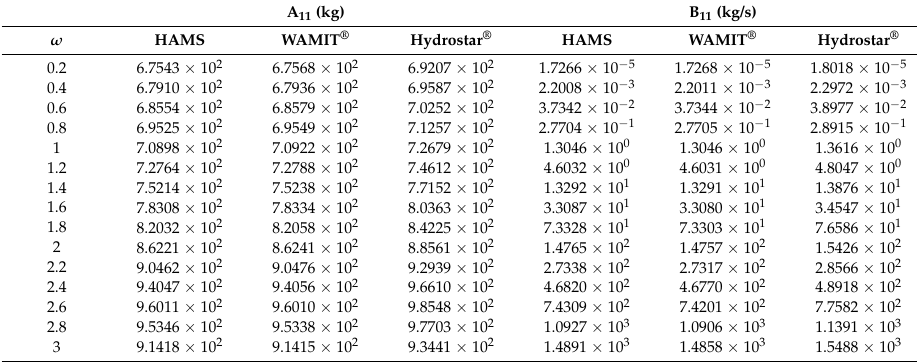
Figure 9. Hydrodynamic mesh of the immersed part of a truncated circular cylinder for use in HAMS, WAMIT ® , and Hydrostar ®. Table 1. Hydrostatic quantities of the truncated circular cylinder calculated by HAMS, WAMIT ® , and Hydrostar ® , under the infinite water depth.